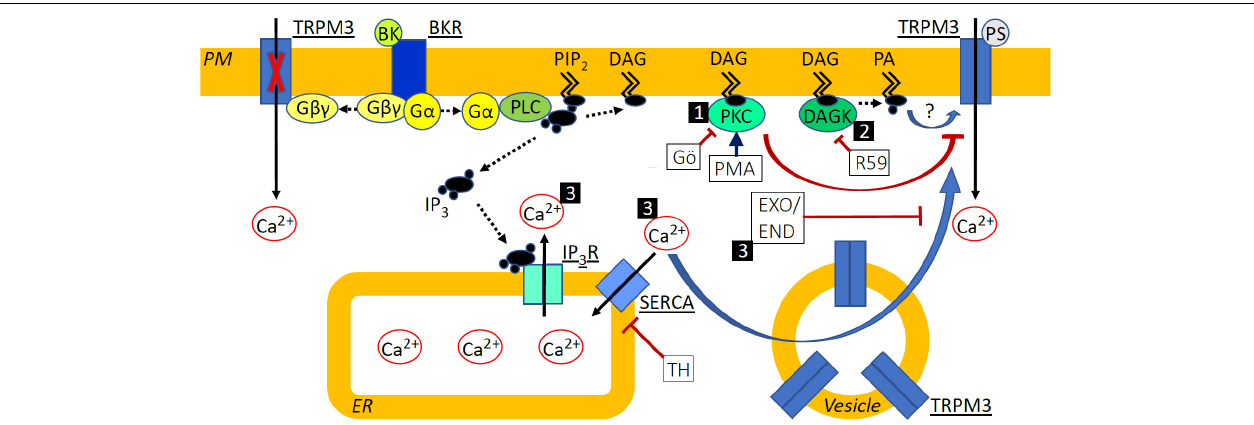
FIGURE 8 | Schematic indicating signal transduction pathways deriving from BKR activation and affecting TRPM3 sensitization. (1) Protein Kinase C (PKC) activation with phorbol-12-myristate-13-acetate (PMA) de-sensitized TRPM3 responses to pregnenolone sulfate (PS), while inhibition with Gö6983 (GÖ) did not. (2) Diacylglycerol (DAG) kinase (DAGK) inhibition with R-59-022 (R59) prevented sensitization of TRPM3 by bradykinin (BK) and we speculate that this effect could be mediated by a reduction in the DAG metabolite phosphatidic acid (PA) or by accumulated DAG, directly influencing TRPM3 function in a positive or negative fashion, respectively. (3) Elevated cytosolic calcium (Ca 2 + ) via inhibition of SERCA with thapsigargin (TH) or following BK receptor (BKR) activation sensitized TRPM3 to PS and increased exocytosis of vesicular TRPM3 may contribute to this. Inhibition of exocytosis with either exo1 (EXO) or endosidin 2 (END) prevented sensitization of TRPM3 by BK and we hypothesize that this effect could be explained by the prevention of TRPM3 accumulation at the cell surface. PM, plasma membrane; PIP 2 , phosphatidyl inositol bisphosphate; G α / βγ , G protein α / βγ subunit; PLC, phospholipase C; IP 3 , inositol trisphosphate; IP 3 R, IP 3 receptor; ER, endoplasmic reticulum. Solid black arrows indicate Ca 2 + movement; dashed black arrows indicate translocation or modification of molecules; blue arrows indicate activation or sensitization; red arrows indicate inhibition or